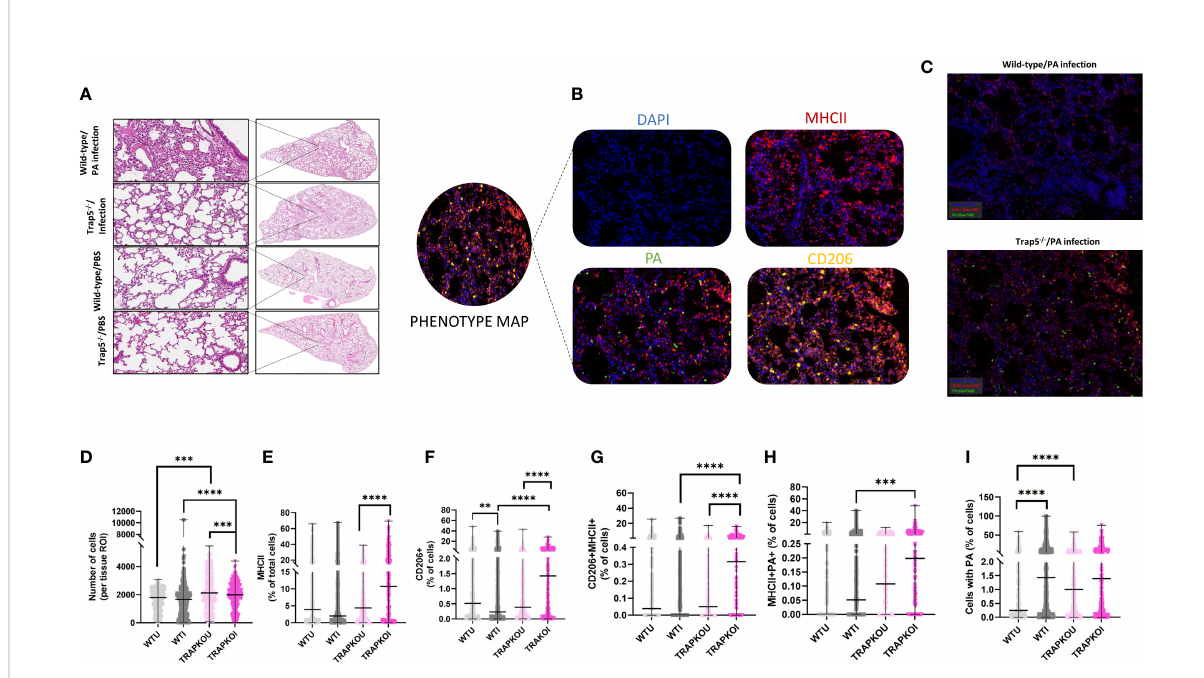
FIGURE 4 Trap5 depletion increases lung speci fi c immune cell content. (A) Haemotoxylin & eosin staining of wild-type and Trap5 -/- murine lungs. (B) Phenotype mapping of multispectral imaging (MSI) showing representative individual stains for each antibody used. (C) Multispectral images (MSI) were obtained from 9 animals in each group using Vectra 3 Automated Quantitative Pathology Imaging System (Akoya). The total number of MSI/group were WT uninfected n = 296, WT infected n = 372, KO uninfected n = 373, KO infected n = 337. (D-I) Data were quanti fi ed and plotted using InForm Tissue Analysis Software (Akoya) for (D) Total cell number; (E) MHC II + cells; (F) CD206+ cells; (G) CD206+/MHCII+ cells; (H) MHCII+/PA+ cells; and fi nally (I) cells containing PA. WTU- wild-type/uninfected; WTI- wild-type/infected; TRAPKOU- Trap5 -/- / uninfected; TRAPKOU- Trap5 -/- / infected. Major histocompatibility complex II (MHC II); Cluster of Differentiation 206 (CD206); PA ( P. aeruginosa ).